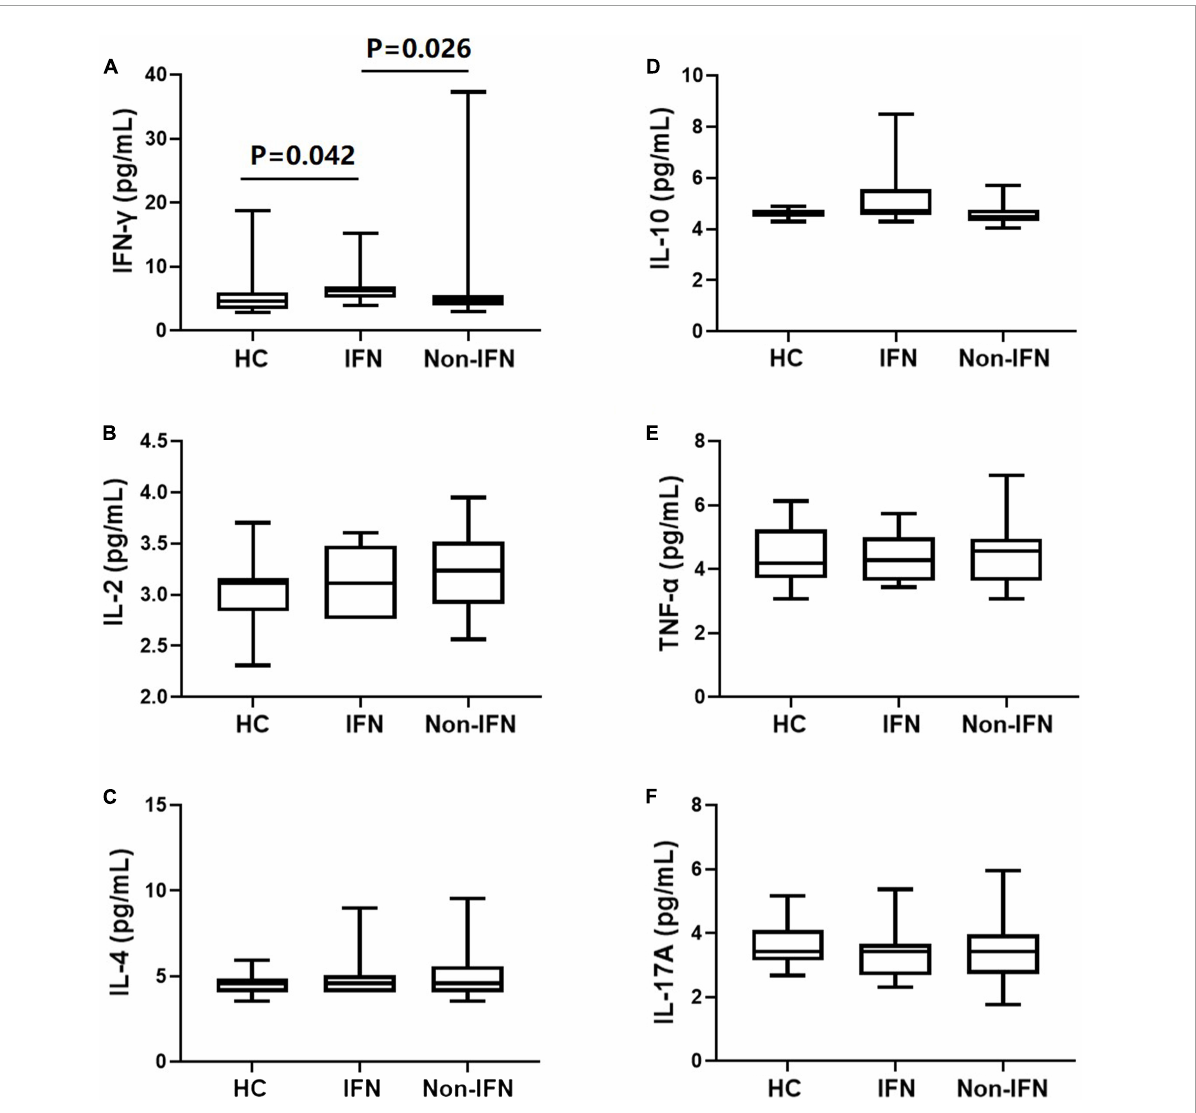
FIGURE7 Comparison of serum cytokines in HCs, the IFN group, and the non-IFN group. (A) IFN- γ levels were significantly higher in the IFN group than in the non-IFN group and HCs. (B–F) No significant difference was observed in the peripheral levels of IL-2, IL-4, IL-10, TNF- α , and IL-17A among the three groups. The IFN group, patients with CHB receiving nucleos(t)ide analogs (NAs) combined with Peg-interferon-alpha therapy; the non-IFN group, patients with CHB receiving NAs monotherapy; IFN- γ , interferon- γ ; IL, interleukin; TNF- α , tumor necrosis factor- α